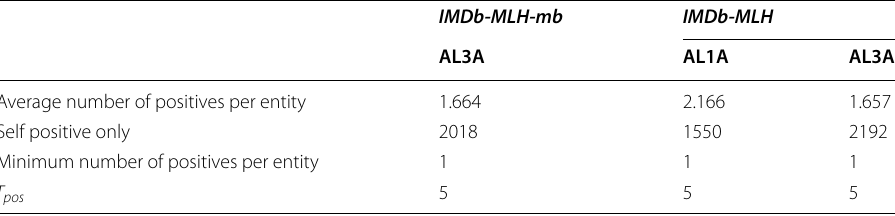
Table 4 Summary of positive sampling